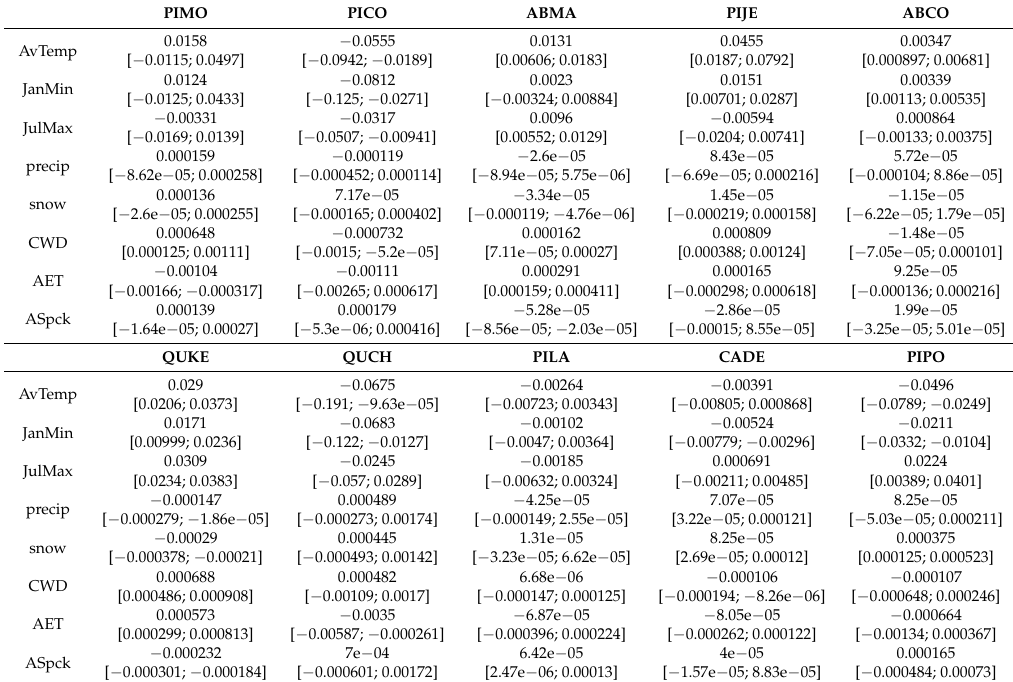
Table A3. Climate parameter estimated by a different model for each climate variable (model used for the selection). 95% CI in